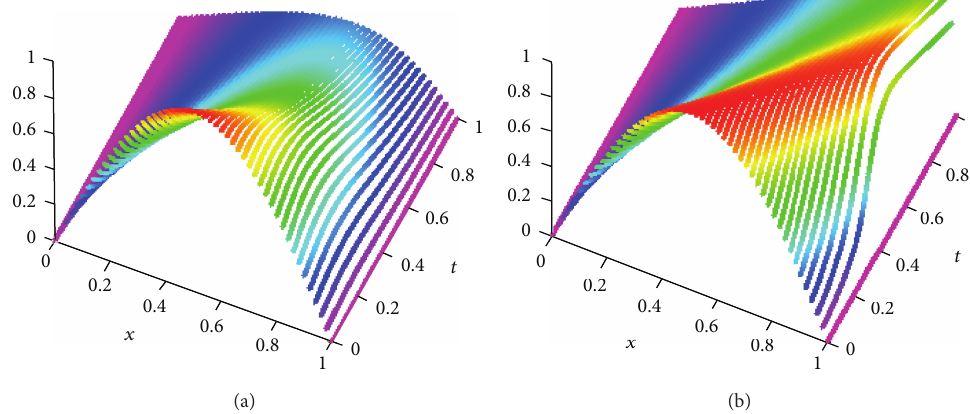
Figure 1: The space-time graph of the estimated solution of Burgers’ equation by using IMQQI for 𝑥 ∈ [0, 1] , 𝑡 ∈ [0, 1] , 𝜐 = 0.1 (a), and 𝜐 = 0.01 (b) of Experiment 1.